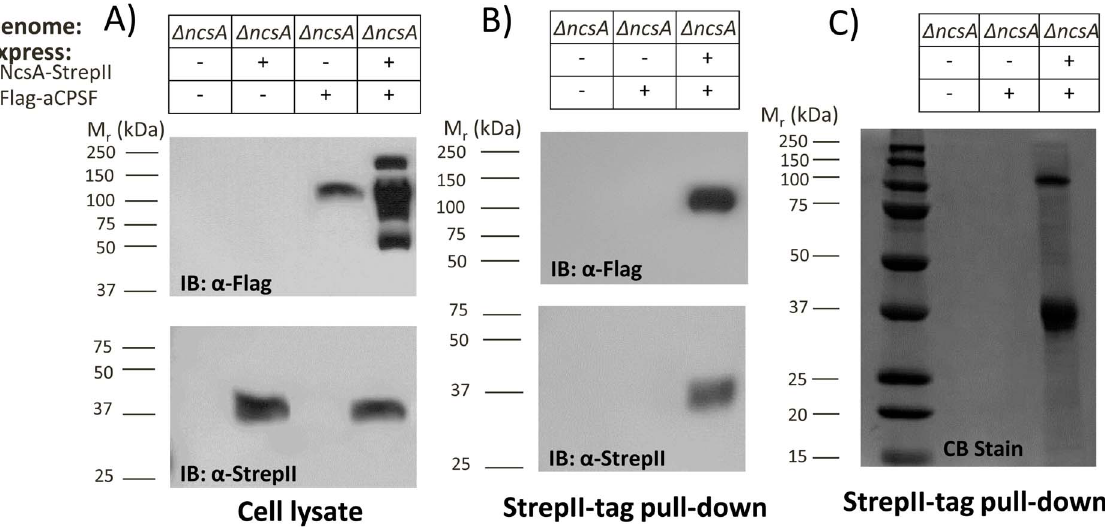
Figure 7. NcsA forms a complex with an archaeal CPSF1 homolog. A) Cell lysate and B) StrepII purified fractions of an D ncsA mutant expressing NcsA-StrepII and/or Flag-aCPSF were probed with a -Flag and a -StrepII antibodies as indicated. C) Coomassie blue (CB) stain of StrepII- purified fractions as indicated. Molecular weight markers are indicated to the left of each blot. Pull down assays were from 50 ml cultures. See Methods section for details.